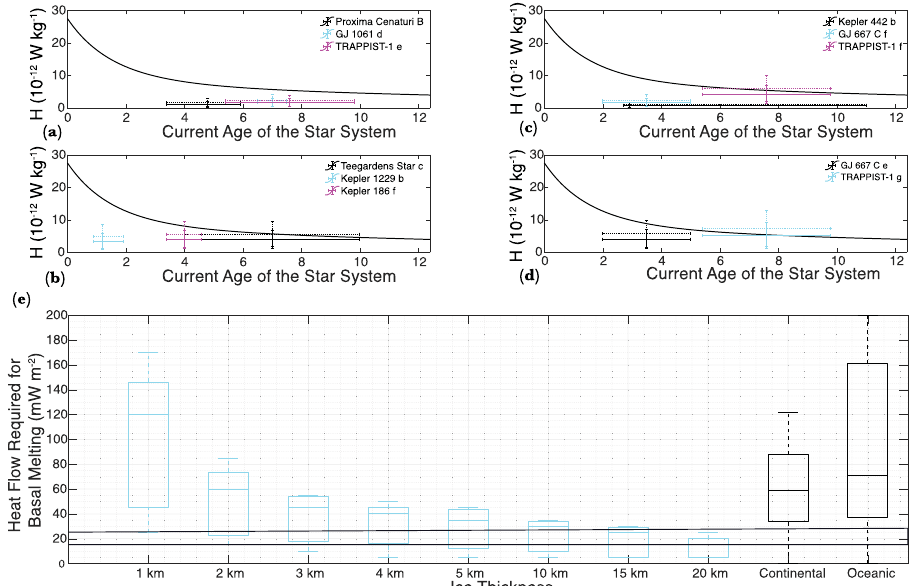
Fig. 9 | Radiogenic heat-production rate required for basal melting compared with the age-dependent heat production rate of cosmochemically Earth-like planets.a Theblackcurveshowstheradiogenicheatproductionrateasafunction oftimeforcosmochemicallyEarth-likeplanets.Theverticalextentoftheerrorbars shows the heat production rate requiredfor basal melting ofice sheets 1 – 20kmin thickness (also see Supplementary Fig. 2) on Proxima Centauri B, GJ 1061 ( d ), and TRAPPIST-1 ( e ). The dotted error bars show the range of heat production required for basal melting assuming Earth-like core mass fraction. The horizontal error bar